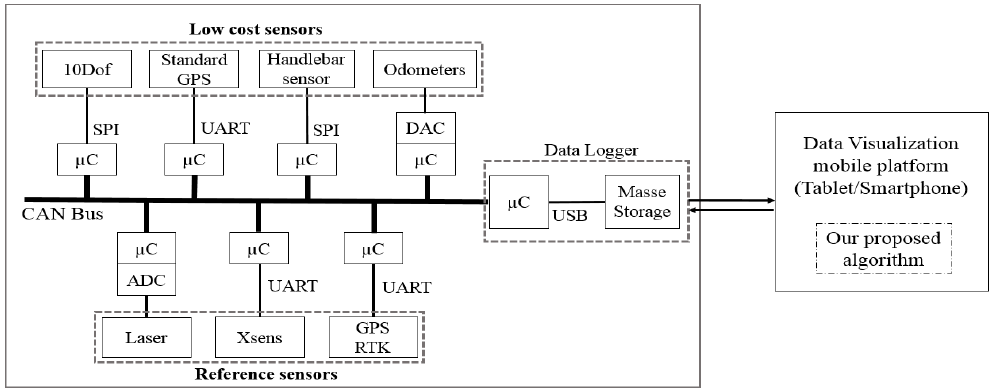
Figure 2. System architecture.